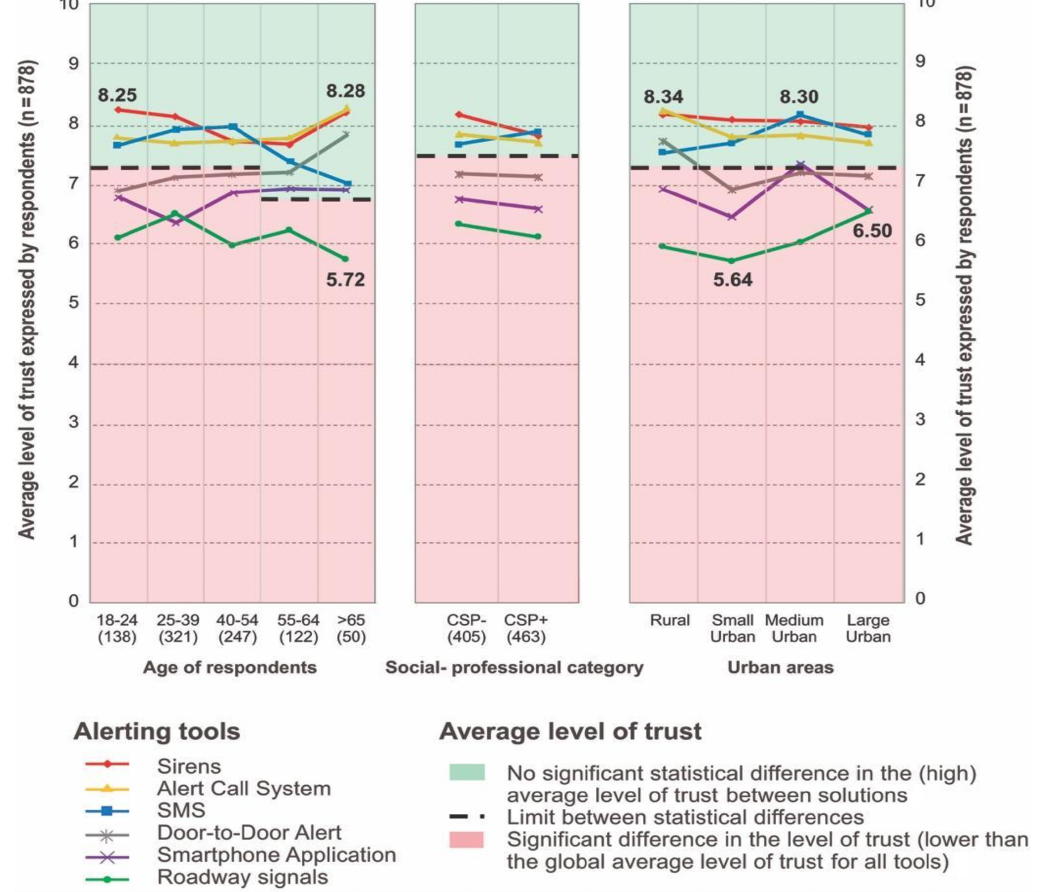
Figure 8. Average level of trust expressed by respondents for different means of communicating alerts.